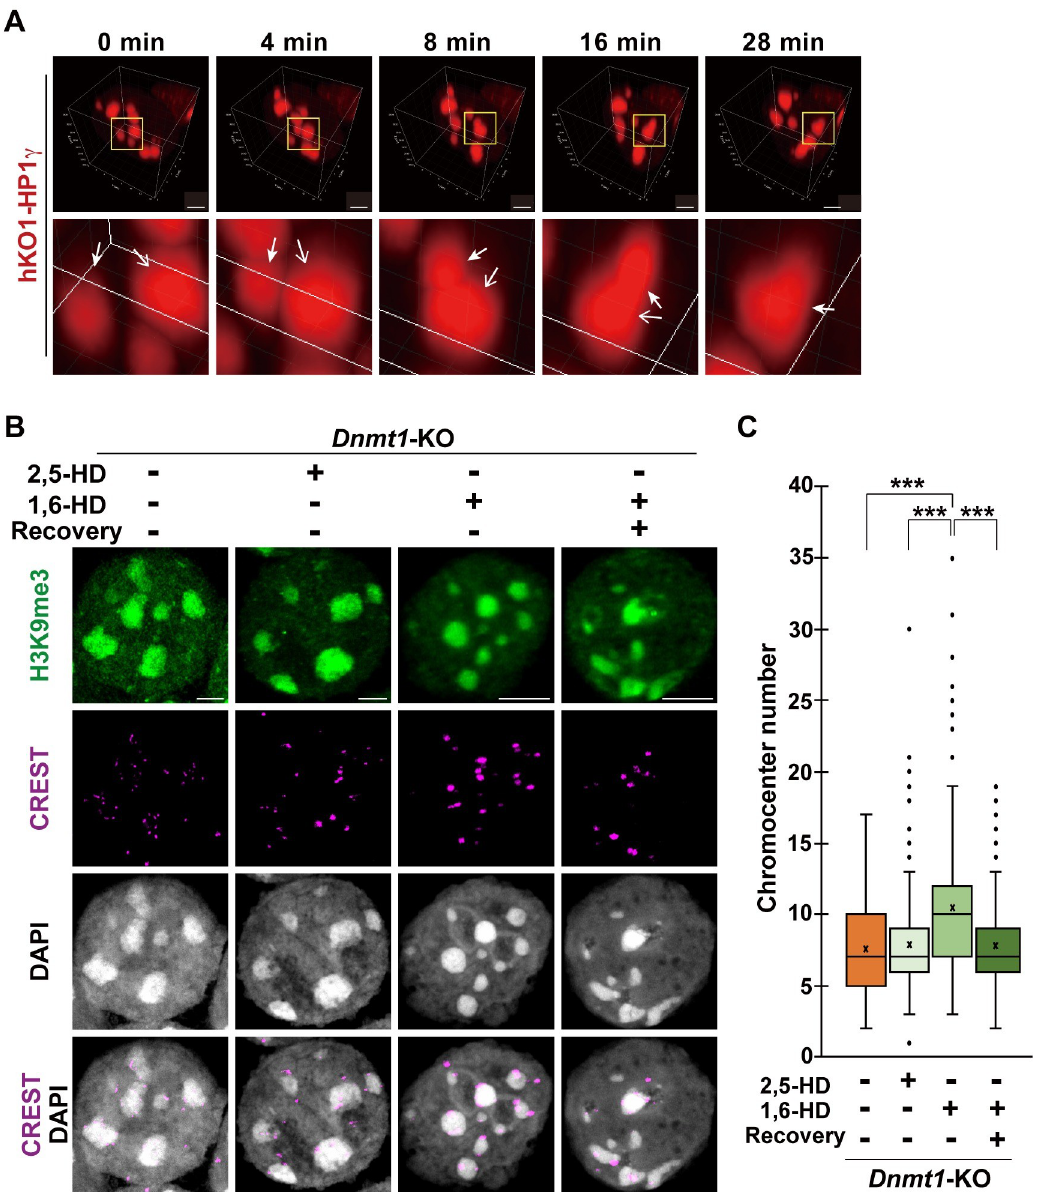
Fig 4. Liquid-liquid phase separation (LLPS) drives chromocenter clustering in the DNA hypomethylated cells. (A) : Series of time-lapse 3D reconstruction images of the Dnmt1 -KO ESCs expressing hKO1-HP1 γ . Yellow squares indicate the region highlighted at the bottom panel. White arrows indicate the chromocenters undergoing the fusion. Images were captured and cropped from S1 Movie. Scale bar, 3 μ m. (B) : Representative immunostaining images of surface-spread nuclei of the Dnmt1 -KO ESCs with or without 1,6-hexanediol (HD) treatment. About 10% of 2,5- or 1,6-HD were treated for 1 min. For the recovery experiment, cells were incubated in an ESC culture medium for 1 h. Scale bar, 5 μ m. (C) : Boxplot showing the number of distinct chromocenters in the nuclei of the Dnmt1 -ESCs in the individual condition, related to (B). No treatment, n = 71; 2,5-HD treatment, n = 222; 1,6-HD treatment, n = 217; 1,6-HD treatment with recovery culture, n = 199. P values were calculated using the Mann-Whitney U-test. ��� P <